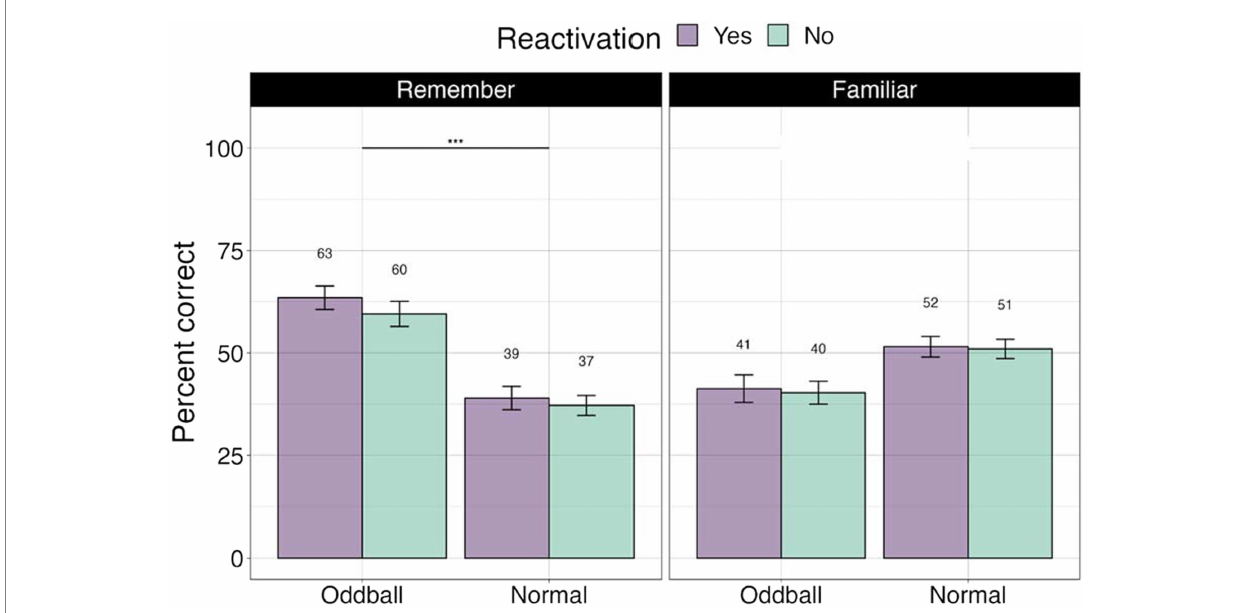
FIGURE 4 Percent correct for the visual recognition test by self-reported confidence levels in Experiment 1. ***The significance of 0 < 0.001. Error bars represent standard errors of the